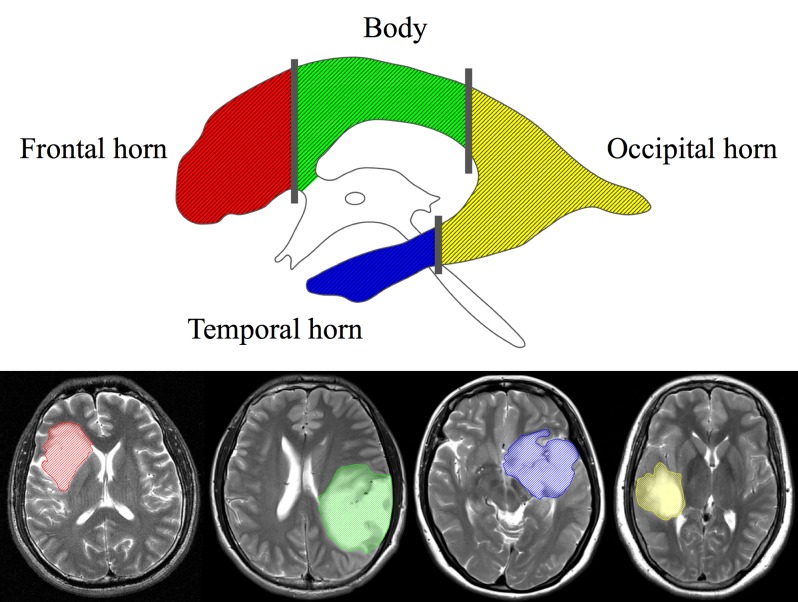
Subregions of the subventricular zone (SVZ).The four subregions are each shown in a different color (upper panel). Examples of tumors involved in each region are depicted with the corresponding color (lower panel).